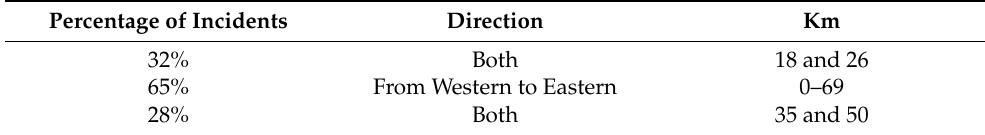
Table 3. Percentage of incidents per direction per